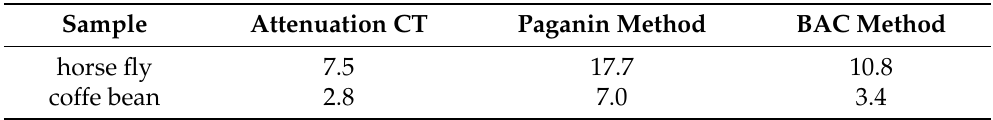
Figure 4. ( a ) Propagation based projection image of the horse fly. ( b ) Illustration of the result of the optimization of the α and γ parameters of the BAC method showing a comparison of the original and BAC corrected image gray scale profiles over the white horizontal line shown in ( a ). Table 1. CNR values between sample material and air for the different CT images and reconstruction methods. For the ROIs used to determine the CNR see Figures 3 and